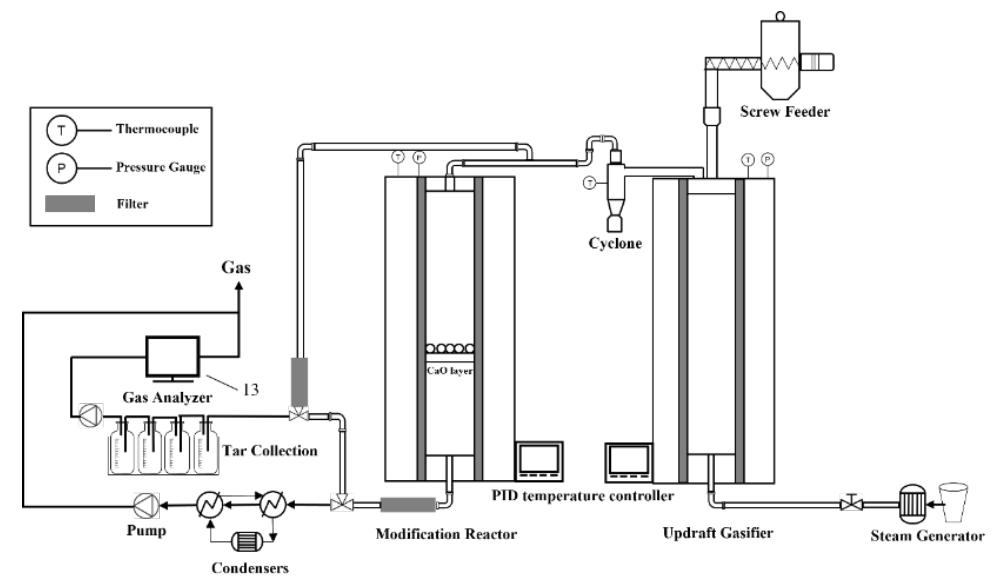
Figure 2. Schematic diagram of experiment setup.